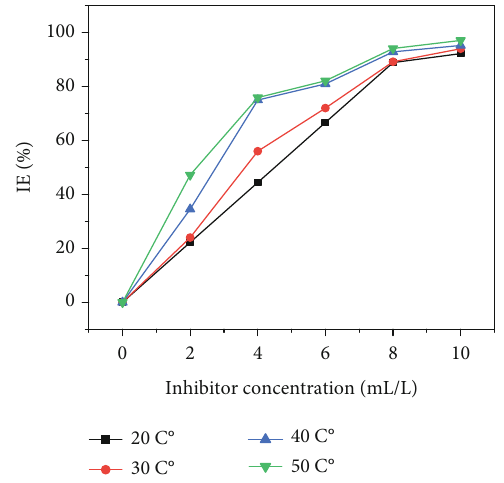
Figure 3: The impact of temperature on inhibitive e ffi ciency of PDL extract for aluminium corrosion in 1 M hydrochloric